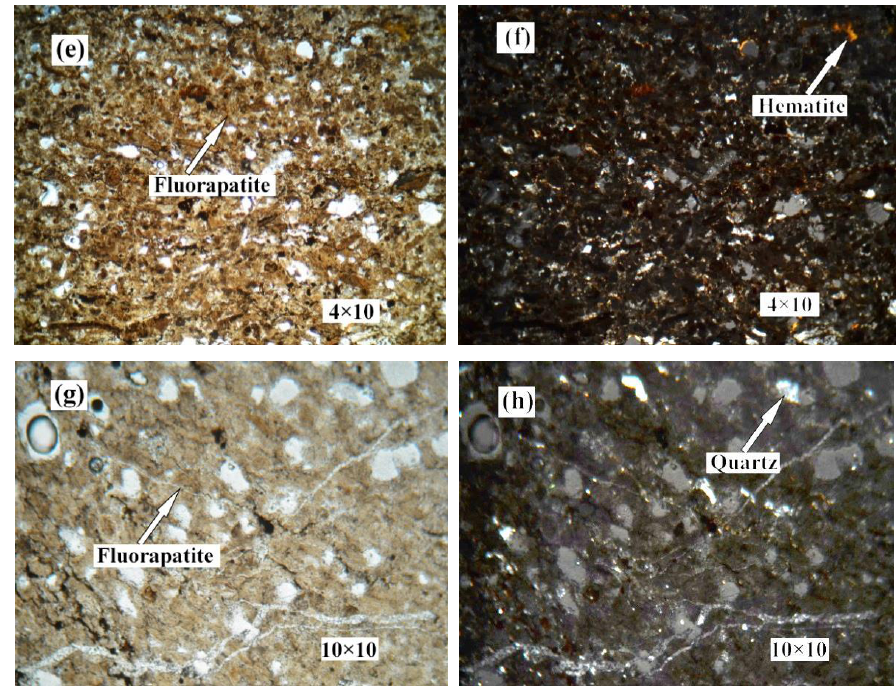
Figure 2. Photomicrographs of phosphorite. ( a ) no.1 crossed nicols. ( b ) no.1 perpendicular polarized light. ( c ) no.2 plane polarized light. ( d ) no.2 crossed nicols. ( e ) no.4 plane polarized light. ( f ) no.4 crossed nicols. ( g ) no.5 plane polarized light. ( h ) no.5 crossed nicols.